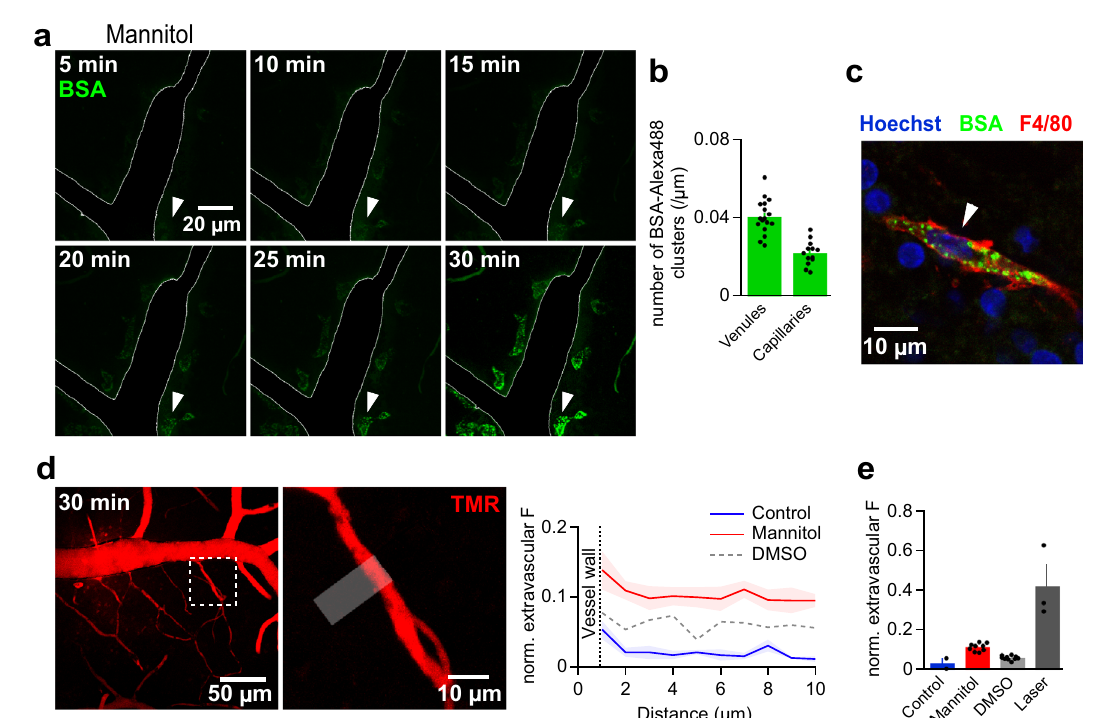
Fig. 6 | Hyperosmolar mannitol enhances TMR and BSA extravasation to the parenchyma. a Time lapse images showing the gradual extravasation and sub- sequent accumulation of BSA-Alexa488 (BSA) in macrophages recruited upon perfusing 15%mannitolinto vasculature, which wasveri fi ed byimmuno fl uorescent labelling (see c). For better clarity of BSA clusters, the intravascular fl uorescence wasdeliberately removedusing Fijisoftwareand the vesselwas outlined manually. Images are representative of 4 experiments. b The number of BSA-Alexa488 clus- terswithinmacrophages(per µ mlength)inthevicinityofvenulesistwiceashighas that next to capillaries (12 injections/ 4 animals, n ROI for venules = 17, n ROI for capillaries = 13). c Immuno fl uorescent labelling of macrophages (F4/80) showing